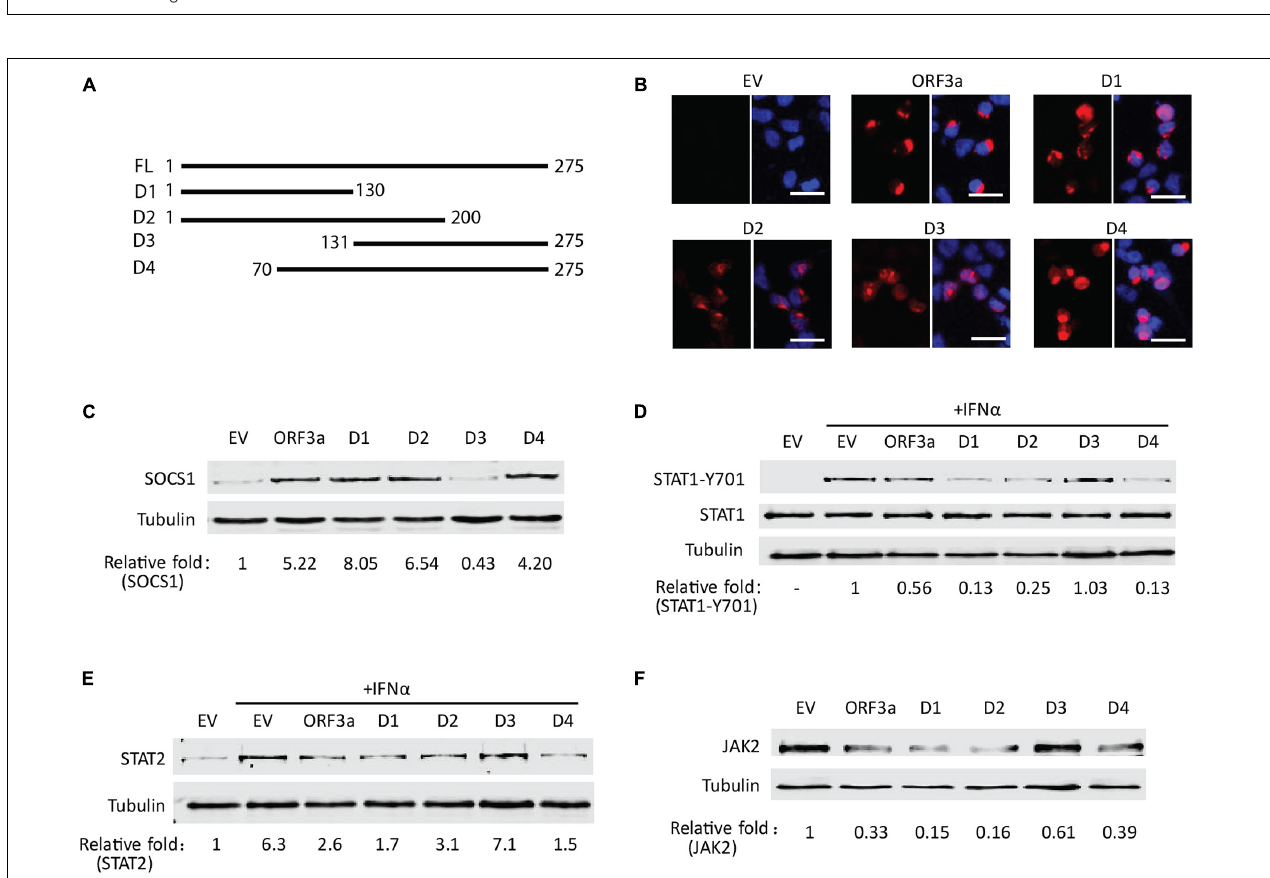
FIGURE 7 | The middle domain of ORF3a appears to be associated with the JAK2 reduction and IFN signaling inhibition. (A) Schematic illustration of full-length (FL) and truncated constructs (D1–D4) of ORF3a. The names of the fragments are indicated on the left. The numbers above the lines indicate starting and ending amino acid positions of ORF3a for the constructs. (B) Immunofluorescence assay showing expression of ORF3a deletion constructs in HEK293T cells. In each panel, the left image shows the expression of EV, ORF3a, or the deletion construct, and the right image shows the overlay with DAPI staining. (C) The levels of SOCS1 in HEK293T cells with expression of ORF3a deletion constructs. The cells were transfected with full-length ORF3a and truncation constructs. At 48 h after transfection, cells were harvested for immunoblotting with antibodies against SOCS1 and tubulin. (D,E) The effect of ORF3a deletion constructs on IFN signaling activation. At 36 h after transfection, the cells were treated with IFN α for another 0.5 or 20 h, then harvested for immunoblotting to detect STAT1-Y701 (D) or STAT2 (E) levels, respectively. (F) The levels of JAK2 in HEK293T cells with expression of ORF3a deletion constructs. Cells were treated similarly to C.